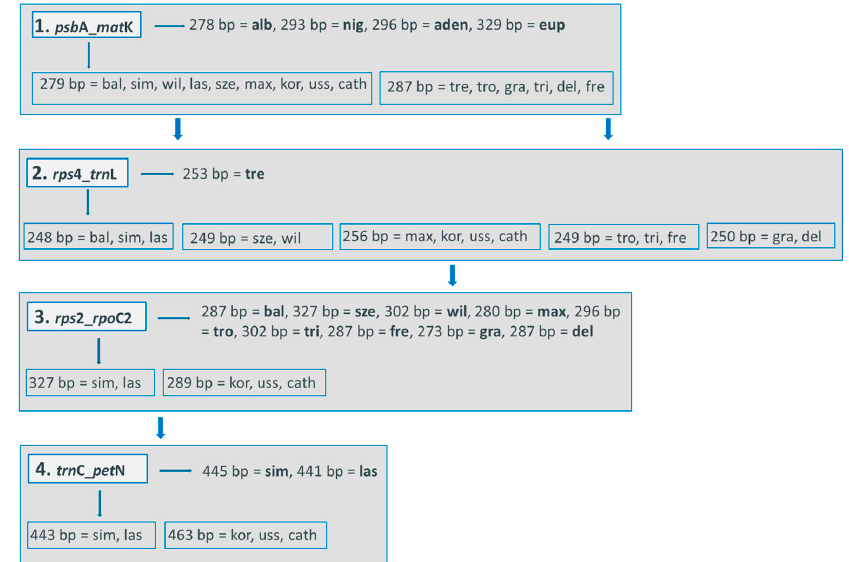
Figure 1. Procedure of exclusion for four cp indels: a step-by-step procedure for the use of indels from four cp regions to differentiate up to 16 of the 19 poplar species. For the fourth step, if P. simonii shows a fragment length of 445 bp and P. lasiocarpa shows a fragment length of 441 bp, then the differentiation of these two species is possible. If the individuals of both species revealed a fragment length of 443 bp, then the species were not differentiated. Abbreviations: aden = P. adenopoda , alb = P. alba , bal = P. balsamifera , cath = P. cathayana , del = P. deltoides , eup = P. euphratica , fre = P. fremontii , gra = P. grandidentata , kor = P. koreana , max = P. maximowicziix , nig = P. nigra , sim = P. simonii , sze = P. szechuanica , tre = P. tremula , tri = P. trichocarpa , tro = P. tremuloides , uss = P. ussuriensis , wil = P. wilsonii. Table 6. Multiplex PCR for the amplification of four cp regions to be analyzed on the ABI3730 Genetic Analyzer.